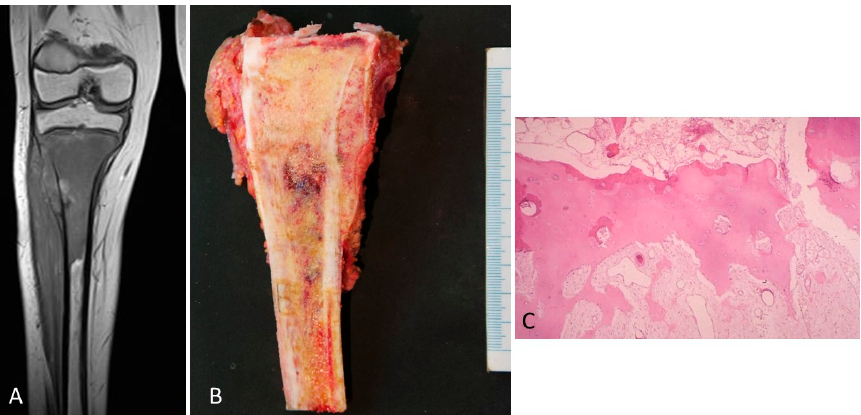
Figure 5. ( A ) MRI of an osteosarcoma in contact with the growth plate. ( B ) The corresponding macroscopy of the osteosarcoma is shown. It is observed that the tumor is placed in contact with the cartilage growth. ( C ) A vascular communication that passes through the physeal cartilage as finger-like growths permeating the calcification and hypertrophic zones is observed. This vascular channel is not composed of tumor cells (H&E, ×